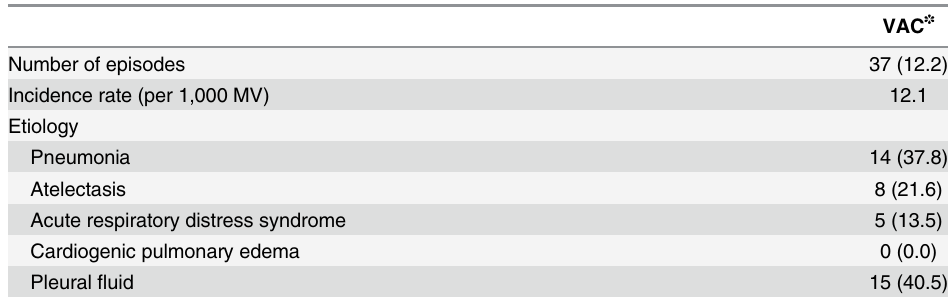
Table 2. Episodes of ventilator-assocated conditions.